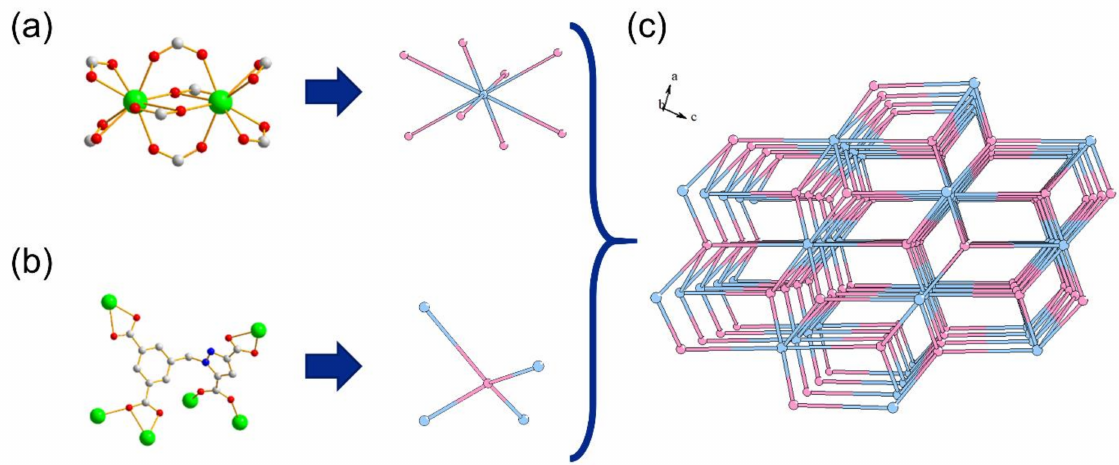
Figure 2. ( a ) The simplified eight-connected node of the binuclear unit. ( b ) The simplified 4-connected linker. ( c ) The (4, 8)-connected topological 3D net with the Schläfli symbol {4 10 .6 14 .8 4 } {4 5 .6} 2